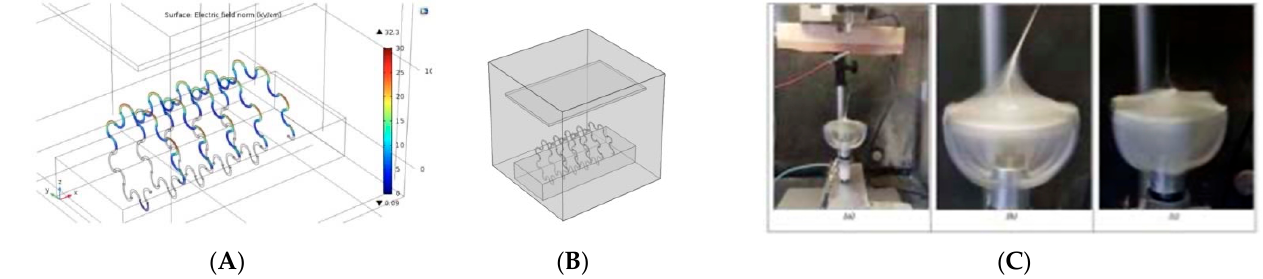
Figure 6. ( A ) COMSOL design of a novel spinneret and its characteristic electrostatic fi eld; ( B ) sche- matic of the novel electrospinning setup; and ( C ) novel rotating collector that permits multiple fi ber pa tt erns—such as aligned vs. random—o ff ering design choices for the living sensor arrays [3].